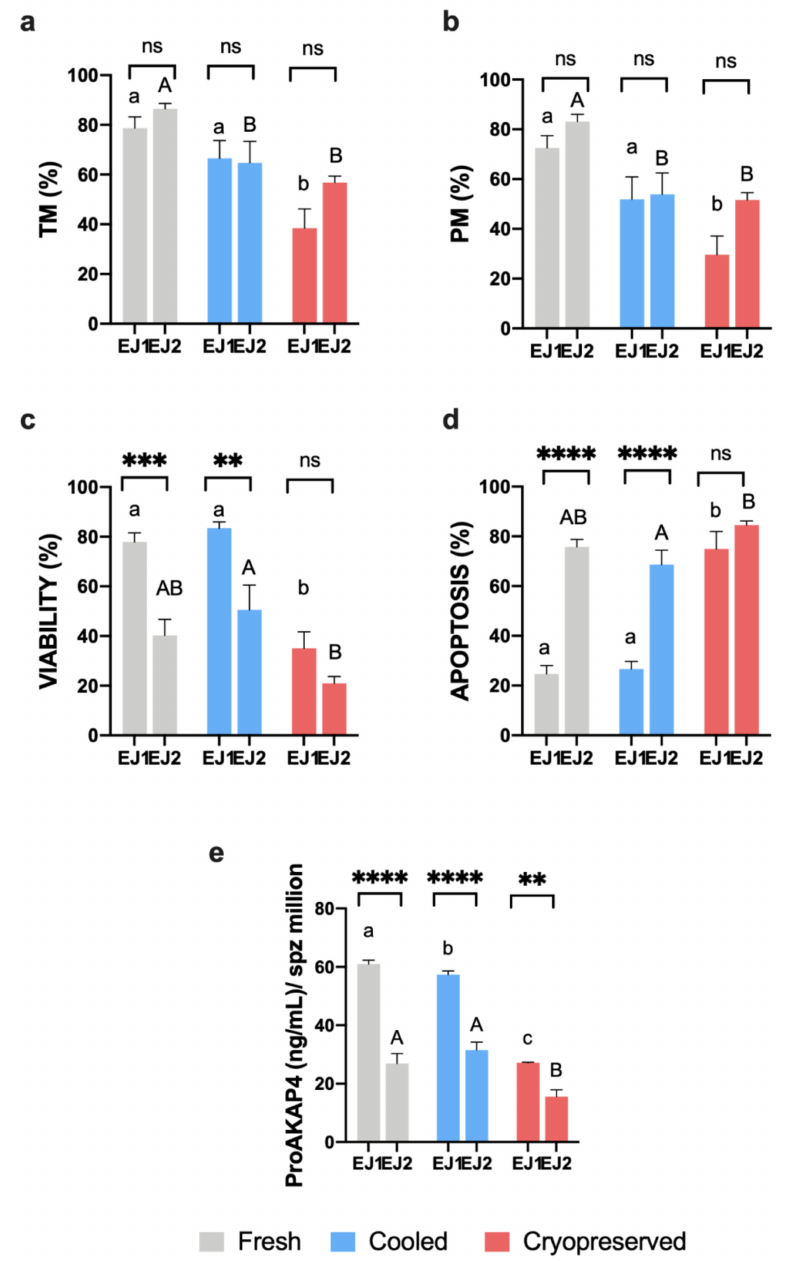
Figure A3. ( a , b ) Ram sperm motility (TM and PM, %), ( c ) viability (%), ( d ) apoptosis (%) and ( e ) ProAKAP4 concentration (ng / mL) in the three experimental groups (fresh, cooled, and cryopreserved samples) in a di ff erent ejaculate (EJ2) of some analyzed males comparing to the first ejaculate obtained (EJ1). EJ1 and EJ2 were obtained in a di ff erent season. A total of six males were analyzed considering the same males in each experimental group. Significant di ff erences ( p < 0.05) between ejaculates in each experimental group are represented with asterisks: two asterisks (**) indicate p < 0.01, three asterisks (***) represent p < 0.001 and four asterisks (****) indicate p < 0.0001. Significant di ff erences among experimental groups in EJ1 are represented with di ff erent lowercase letters. Significant di ff erences among experimental groups in EJ2 are represented with di ff erent capital